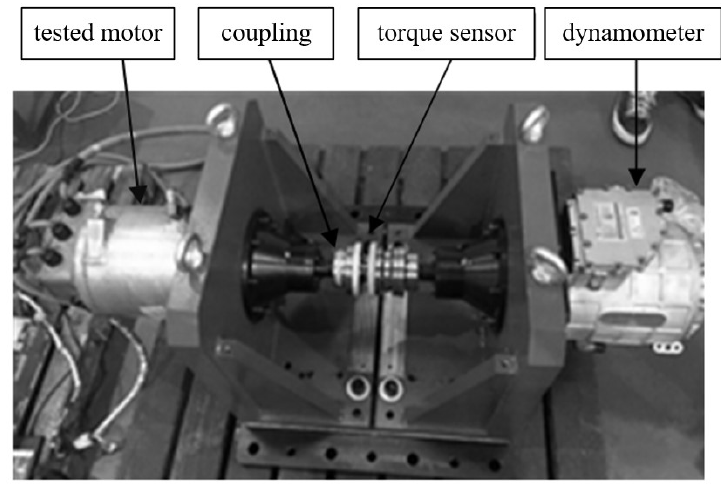
Figure 7. Test Figure 7. Test bench.